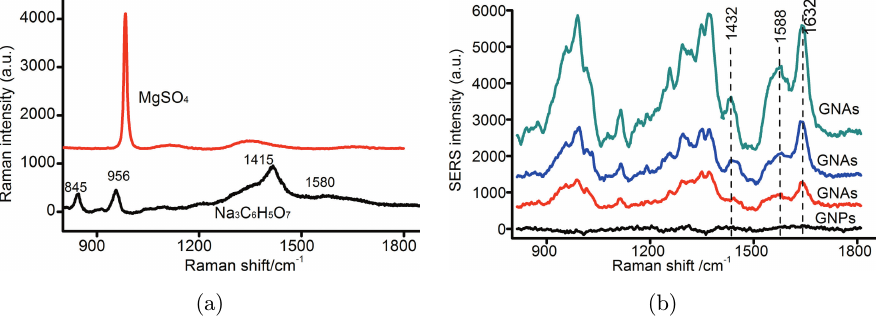
Fig. 3. (a) Normal Raman spectra of magnesium sulphate (MgSO 4 ) and citrate sodium (Na 3 C 6 H 5 O 7 Þ . (b) A SERS spectrum of citrate-coated GNPs and three di®erent spectra of citrate-coated GNAs. No obvious SERS signals for citrate-coated GNPs were visualized. However, intense SERS signals from citrate-coated GNAs were observed. The spectra re°ected the information on citrate group in the nanometer-vicinity of GNAs. The SERS signal intensity of each GNA is highly variable, due to the di®erence of nanoaggregate sizes and shapes in randomly aggregated nanoparticle